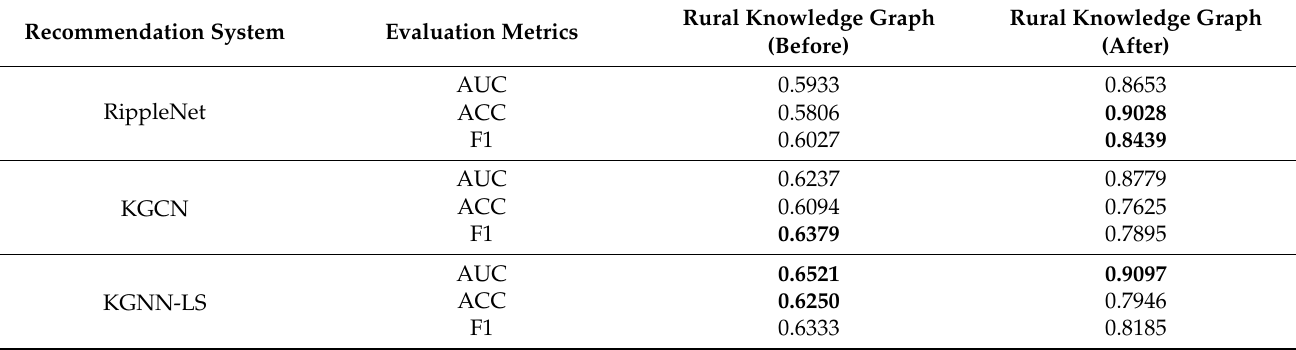
Table 8. Results of two datasets in different recommender systems (in bold are the data with the best performance under this